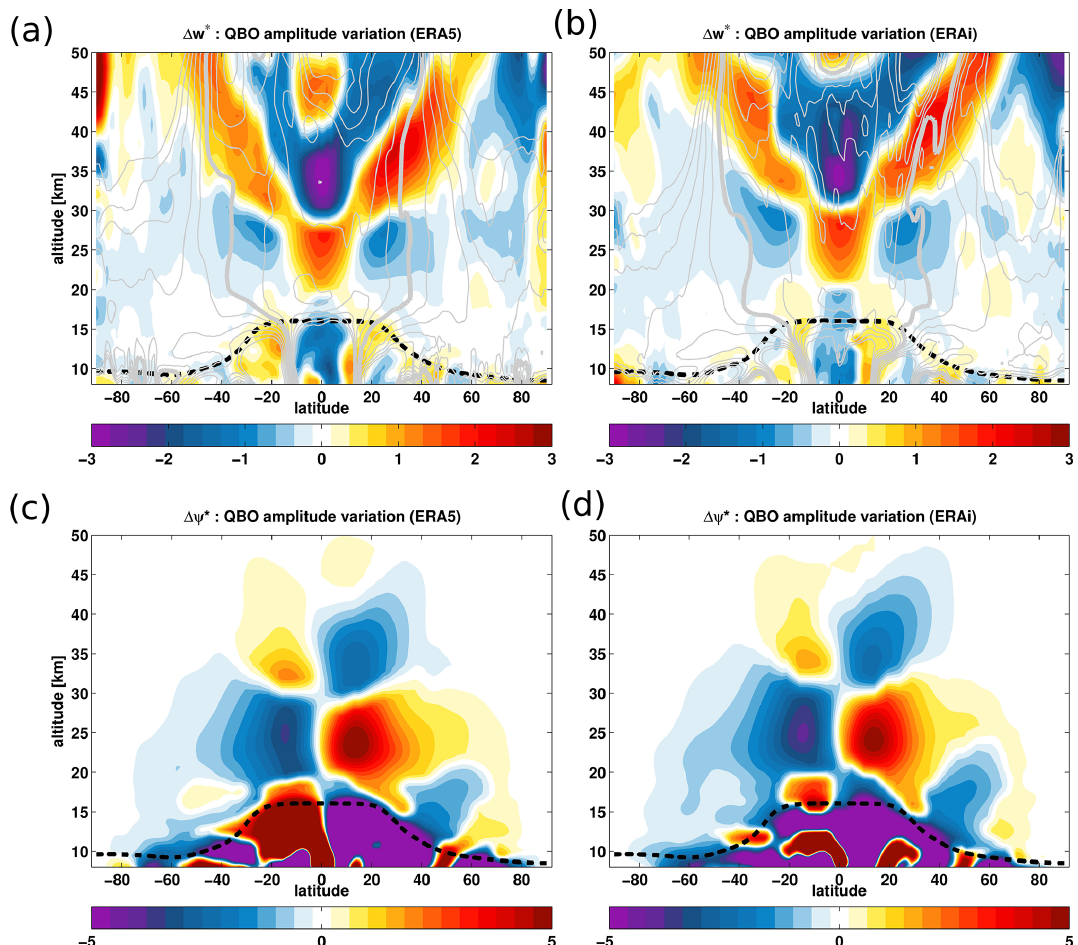
Figure 8. QBO impact on the residual vertical velocity ( w ∗ ) (a, b) and the residual stream function ( ψ ∗ ) (c, d) from the ERA5 (a, c) and the ERA-Interim (b, d) reanalyses for the 1979–2018 period. The amplitude of the w ∗ and ψ ∗ variations attributed to the QBO signal are estimated by fitting on the QBO predictor using the regression model (Eq. 10) and normalized by the standard deviation (SD) of the proxy for the 1979–2018 period. Unit: mms − 1 × SD ( proxy ) . The climatological tropopause from the ERA-Interim is shown in the dashed black line. Zonal mean climatology of w ∗ is superimposed as dashed grey